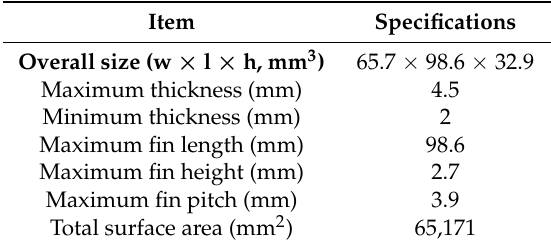
Figure 2. Numerical model of the 36V electronic control unit (ECU) system. ( a ) 3D design of the ECU outer case which works as the heatsink: ( b ) Locations of the major components’ inside the ECU; ( c ) Location of ECU inside the steel chamber of the bicycle and the boundary conditions. Table 1. Heatsink specifications.